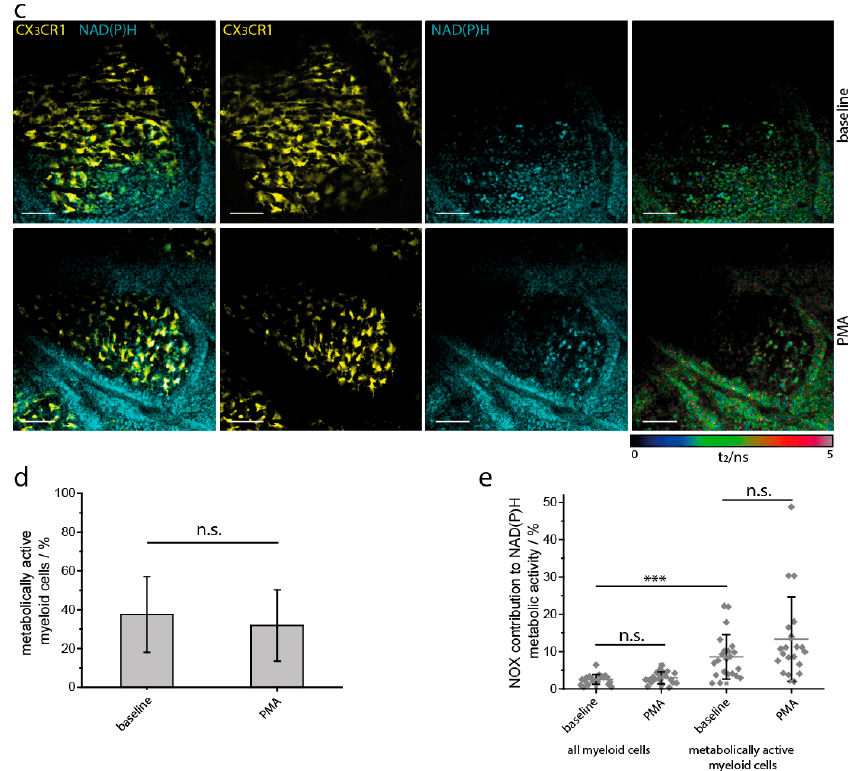
Figure 2. Intravital marker-free fluorescence lifetime imaging (FLIM) reveals NAD(P)H enzymatic activity in the myeloid compartment of the small intestine. ( a ) The upper row show merged and single fluorescence images of an intestinal villus in a CX3CR1-GFP mouse: cyan represents NAD(P)H fluorescence, yellow represents eGFP fluorescence. In each pixel of the image, the NAD(P)H fluorescence signal was acquired in a time-resolved manner and approximated by a bi-exponential function. In this way, the fluorescence lifetimes of the free and of the enzyme-bound NAD(P)H were calculated for each pixel and transformed into a free NAD(P)H fluorescence lifetime image (lower row, left, short fluorescence lifetimes) and an enzyme-bound NAD(P)H fluorescence lifetime image (lower row, right, long fluorescence lifetimes). Scale bar = 50 µm. ( b ) Typical NAD(P)H fluorescence decay curves in different regions of the villus: area 1 shows the NAD(P)H fluorescence signal of the epithelium, area 2 shows the dim NAD(P)H fluorescence signal of a myeloid cell; area 3 shows the bright NAD(P)H fluorescence signal of a myeloid cell. Scale bar = 50 µ m. ( c ) Fluorescence intensity images of intestinal villi under steady-state conditions and upon phorbol myristate acetate (PMA) stimulation in CX3CR1-GFP mice: cyan represents NAD(P) fluorescence, yellow represents GFP fluorescence. Corresponding fluorescence lifetime images of enzyme-bound NAD(P)H, pseudocolored by lifetime. The 100 µ M PMA solution was added locally at the imaging site and imaging was performed 30 min after treatment. Scale bar = 50 µ m. ( d ) Overall NAD(P)H enzymatic activity in the myeloid compartment of the small intestine under steady-state conditions and upon PMA stimulation, as measured by NAD(P)H FLIM. ( e ) NOX enzymes contribution to the overall NAD(P)H enzymatic activity in myeloid cells under steady-state conditions and upon PMA treatment, as it results from NAD(P)H FLIM measurements. The graphs ( d , e ) display results acquired in n = 10 mice, 3–6 investigated areas per mouse. All mice were analyzed both in steady-state and after local treatment with PMA. Analysis in ( d , e ) was performed using one-way ANOVA statistical tests (*** p < 0.001). The overall activity of NAD(P)H-dependent enzymes as defined by NAD(P)H binding is rather low, approx. 40% (Figure 2d). This indicates that most of the resident myeloid cells are resting in terms of NAD(P)H-dependent metabolic activity. Even strong stimulation inducing an oxidative burst, the cell-permeable protein kinase C agonist phorbol myristate acetate (PMA), did not change the